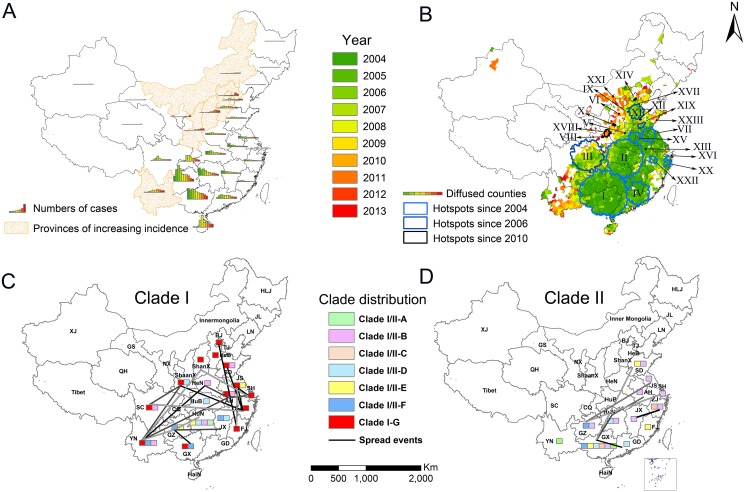
The spatiotemporal dynamic and phylodynamic of Rabies in mainland China.(A) The number of cases at province level over years and provinces of increasing incidence from 2004 to 2013 (B) The diffused counties distribution after 2004 and hotspots movement of human rabies at county level over years (from HS-I to HS-XXIII). The distribution of different sub-clades in clade I (C), clade II (D) and their inferred spread events reconstructed from their MCC trees. The darker line indicates the stronger relative support. Provinces in the figure were coded as follows: HLJ-Heilongjiang, JL-Jilin, LN-Liaoning, BJ-Beijing, TJ-Tianjin, HeB-Hebei, HeN-Henan, ShanX-Shanxi, ShaanX-Shaanxi, SD-Shandong, JS-Jiangsu, SH-Shanghai, AH-Anhui, ZJ-Zhejiang, HuB-Hubei, HuN-Hunan, JX-Jiangxi, FJ-Fujian, GD-Guangdong, GX-Guangxi, YN-Yunnan, HaiN-Hainan, GZ-Guizhou, CQ-Chongqing, NX-Ningxia, SC-Sichuan, QH-Qinghai, GS-Gansu, XJ-Xinjiang, TW-Taiwan.